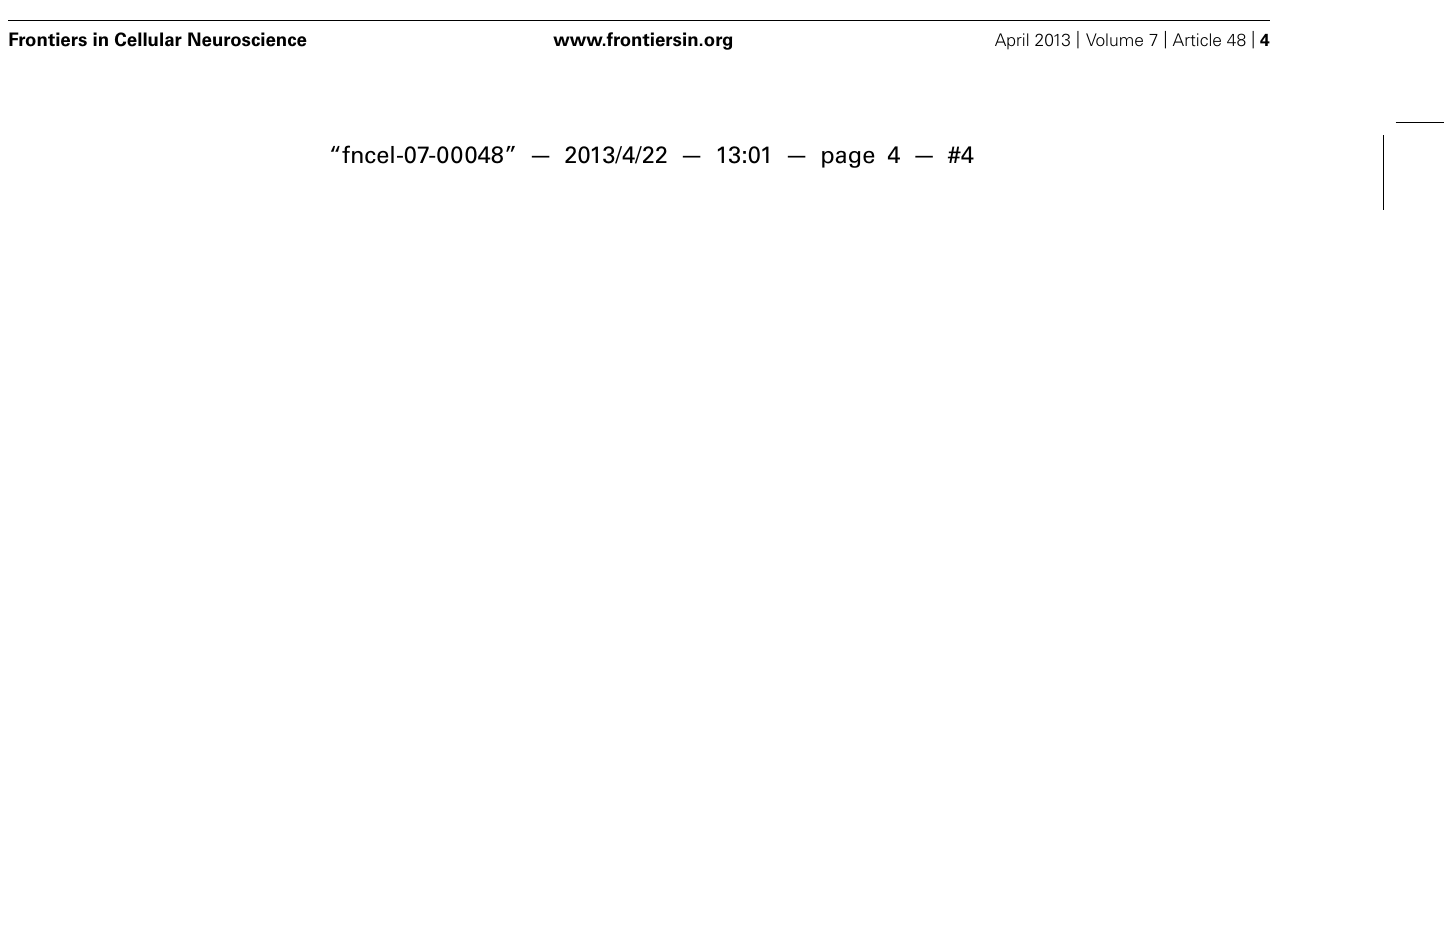
a schematic drawing of a coronal cerebellar slice (right top panel) shows positioning of the multi-electrode array within the DCN. Right, middle and bottom panels: Comparisons of average and cumulative sums of the numbers of spiking cells detected per slice in < + 30 ◦ C ( + 5 to 28 ◦ C, blue) and + 30 to + 34 ◦ C (red) conditions shows that when slices are prepared at warm temperatures, the probability of finding patchable neurons is increased. N = 23 (seven animals) slices cut in cold conditions, 10 (four animals) in